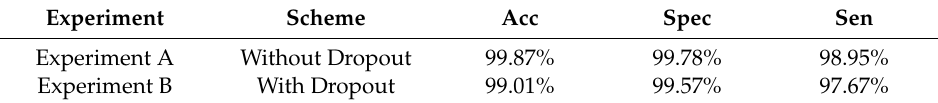
Figure 5. Accuracy and loss of CNN-LSTM training model. Table 4. Average classification performances of the two experiments.